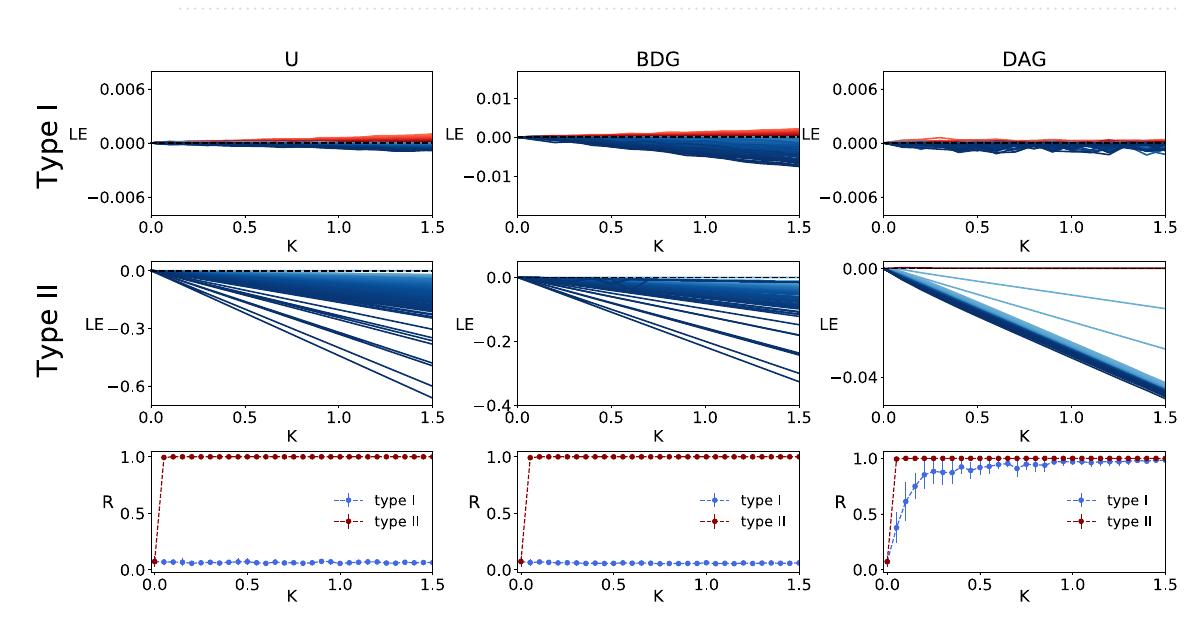
Figure 4. Differences in the synchronization stability of excitatory scale-free networks with various directionalities and neuronal types. Lyapunov exponents versus coupling for (top row) identical type I and (middle row) type II phase oscillators situated on (left column) scale-free undirected graphs, (middle column) BDGs and (right column) DAGs, with N = 200 nodes are illustrated. The sign of the Lyapunov exponents is colour coded, where blue and red indicate negative and positive values, respectively. (Bottom row) The stationary order parameter versus the coupling strength of the scale-free networks with different link- directionalities (i.e. U(Undirected), BDG and DAG) are